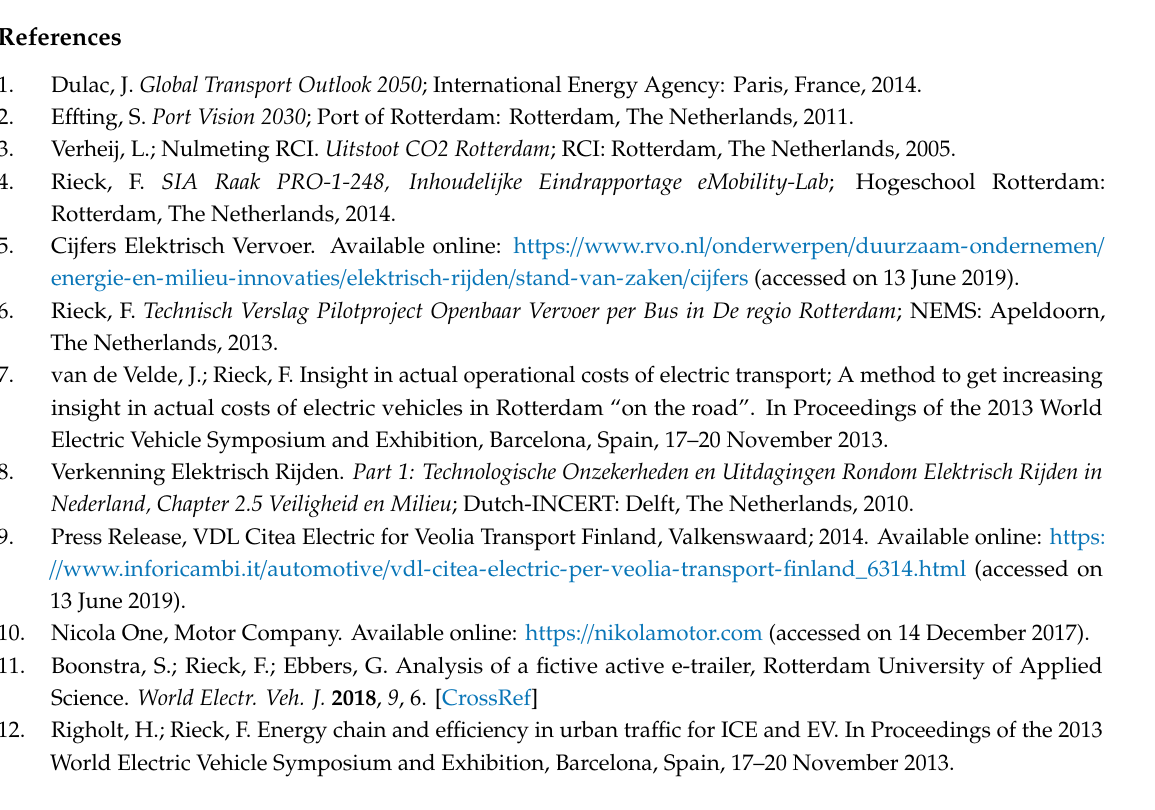
Figure 15. Hype cycle automotive. Reproduced with permission from Gartner, USA 2015.